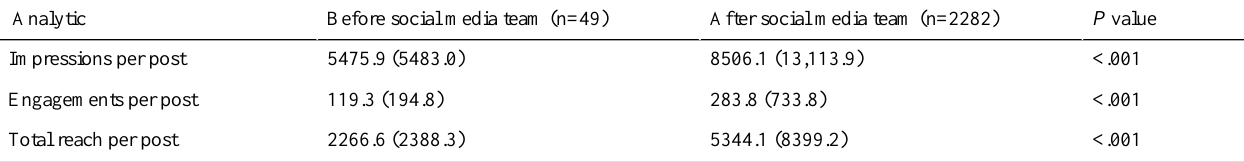
Table 4. Facebook analytics, mean (SD), before and after creation of a social media team.